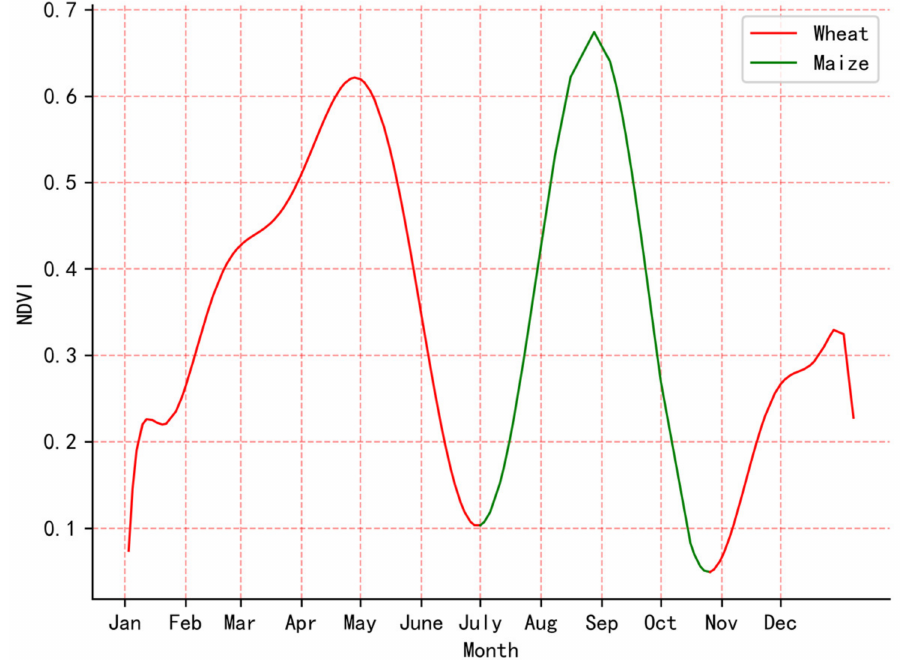
Figure 3. NDVI time series curve of wheat and maize in Shandong Province in